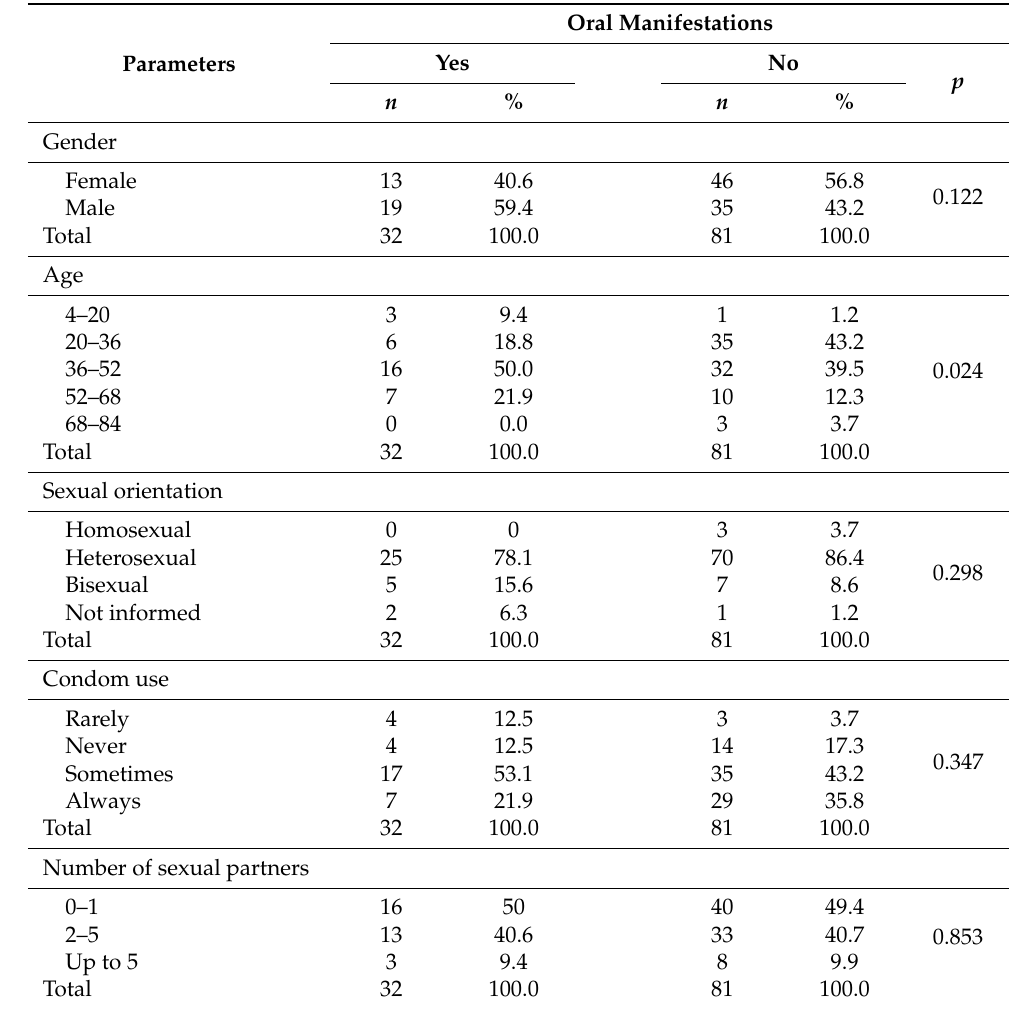
Table 3. Association between oral lesions prevalence, sociodemographic profile and risk factors in patients living with HIV/AIDS treated at the Specialized Outpatient Service (SOE) from January 1999 to January